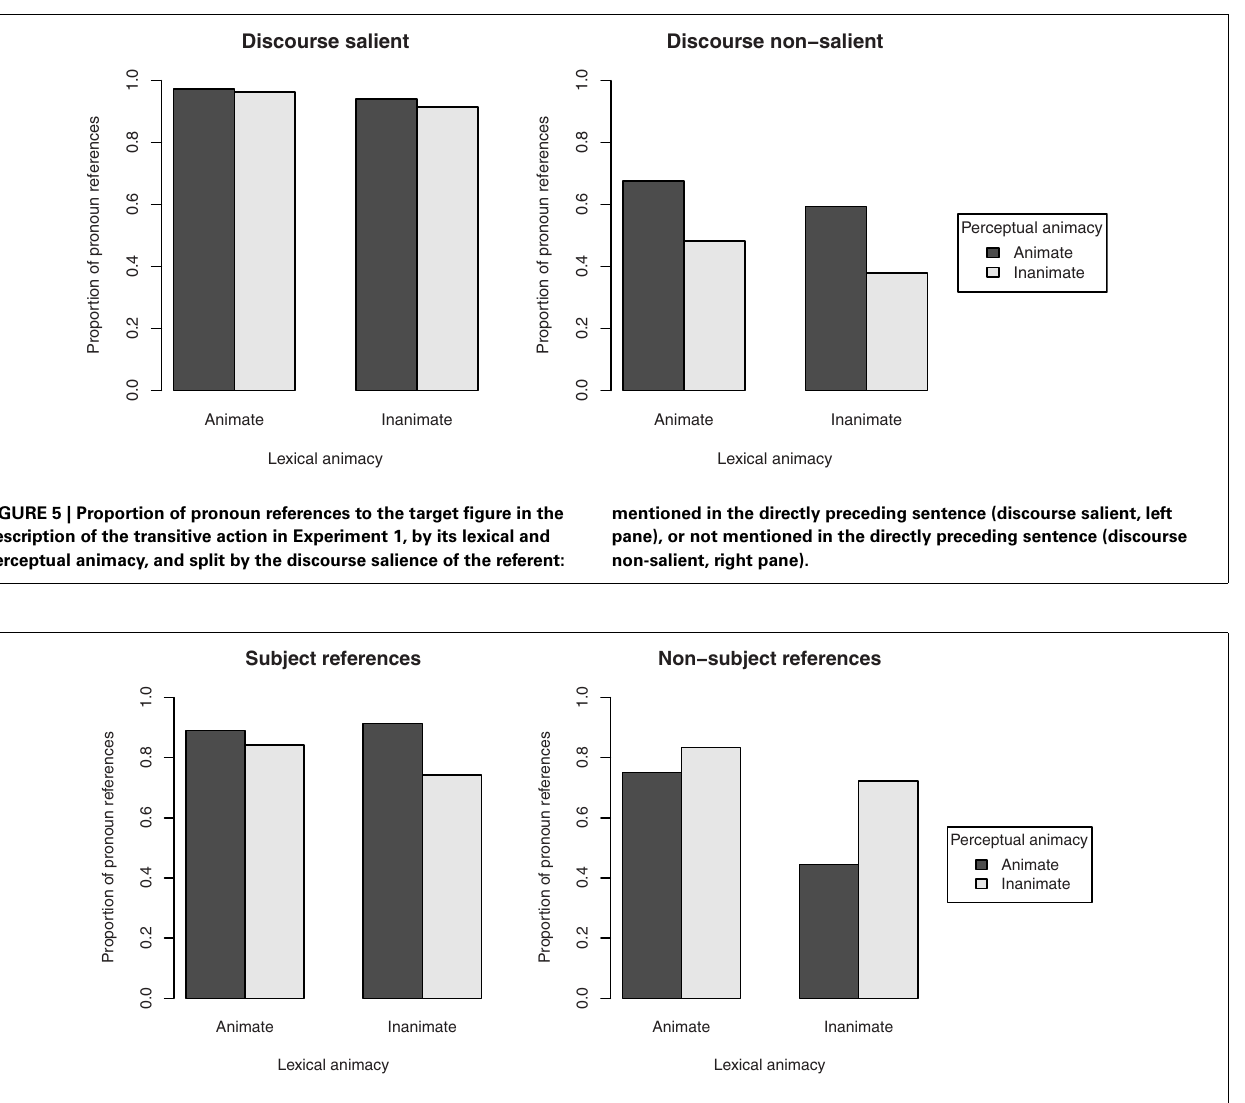
whether it was mentioned as the subject of the sentence or not.